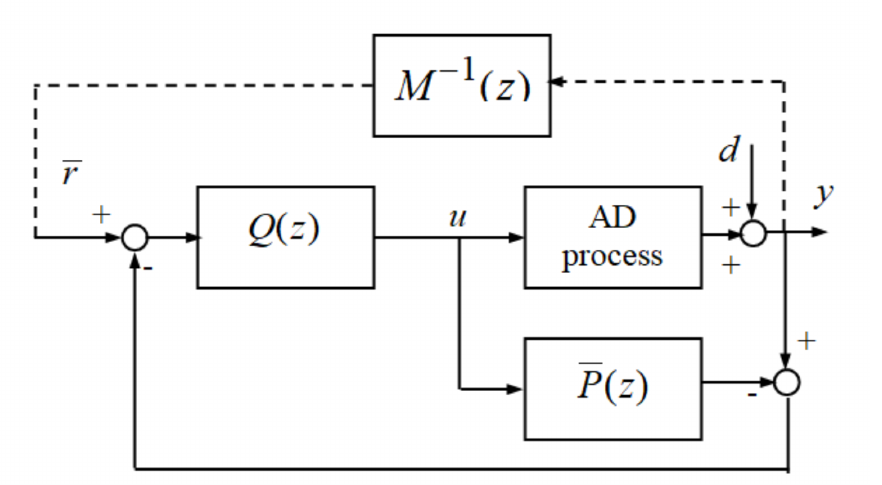
Figure 1. ADP control using the IMC structure: M ( z ) reference model, P ( z ) —process linear model included in the IMC controller, Q ( z )